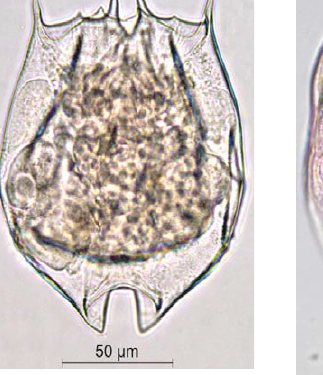
Image 3. Lecane bifurca (Bryce) (ventral view)